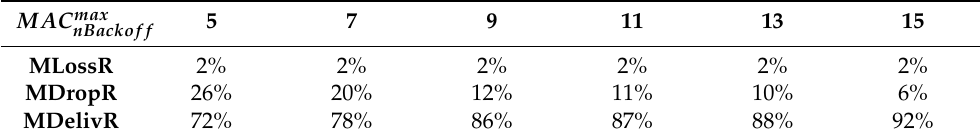
Table 8. Average values of MLossR, MDropR and MDelivR varying the maximum number of backoffs.